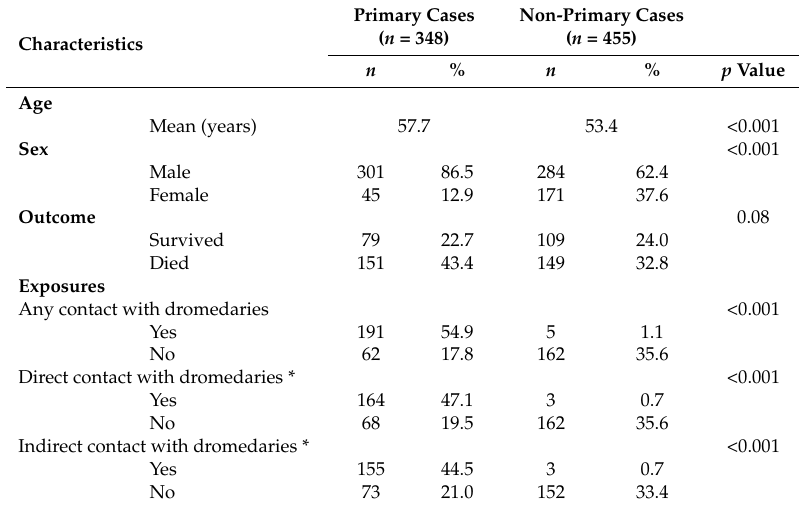
MERS-CoV: Middle East respiratory syndrome coronavirus. Primary case = cases with laboratory confirmation of MERS-CoV infection with no direct epidemiological link to a (confirmed or probable) human MERS case; non-primary case = cases with laboratory confirmation of MERS-CoV infection and with a direct epidemiological link to a (confirmed or probable) human MERS case; * Direct and indirect contact not mutually exclusive—cases may have had both direct and indirect contact with